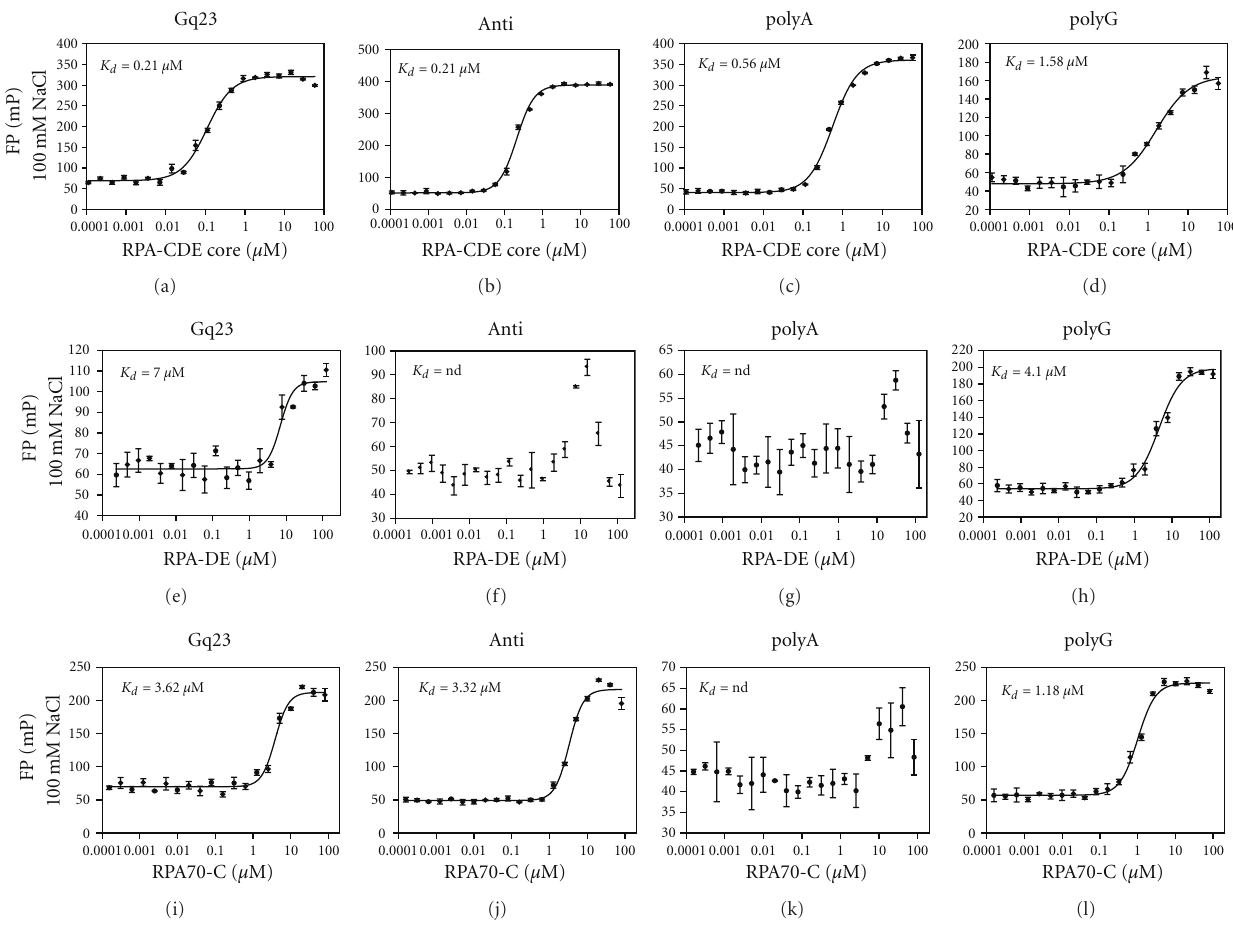
Figure 5: FP ssDNA binding assays for RPA-CDE-core, RPA-DE and RPA-C at 10mM NaCl. Representative binding isotherms are shown. (a)–(d) RPA-CDE-core, (e)–(h) RPA-DE, and (i)–(l) RPA-C. The layout of the figure is the same as described in Figure 4. All experiments were performed at a lowered NaCl concentration to observe binding by the low-a ffi nity RPA constructs and for comparison with RPA-CDE-